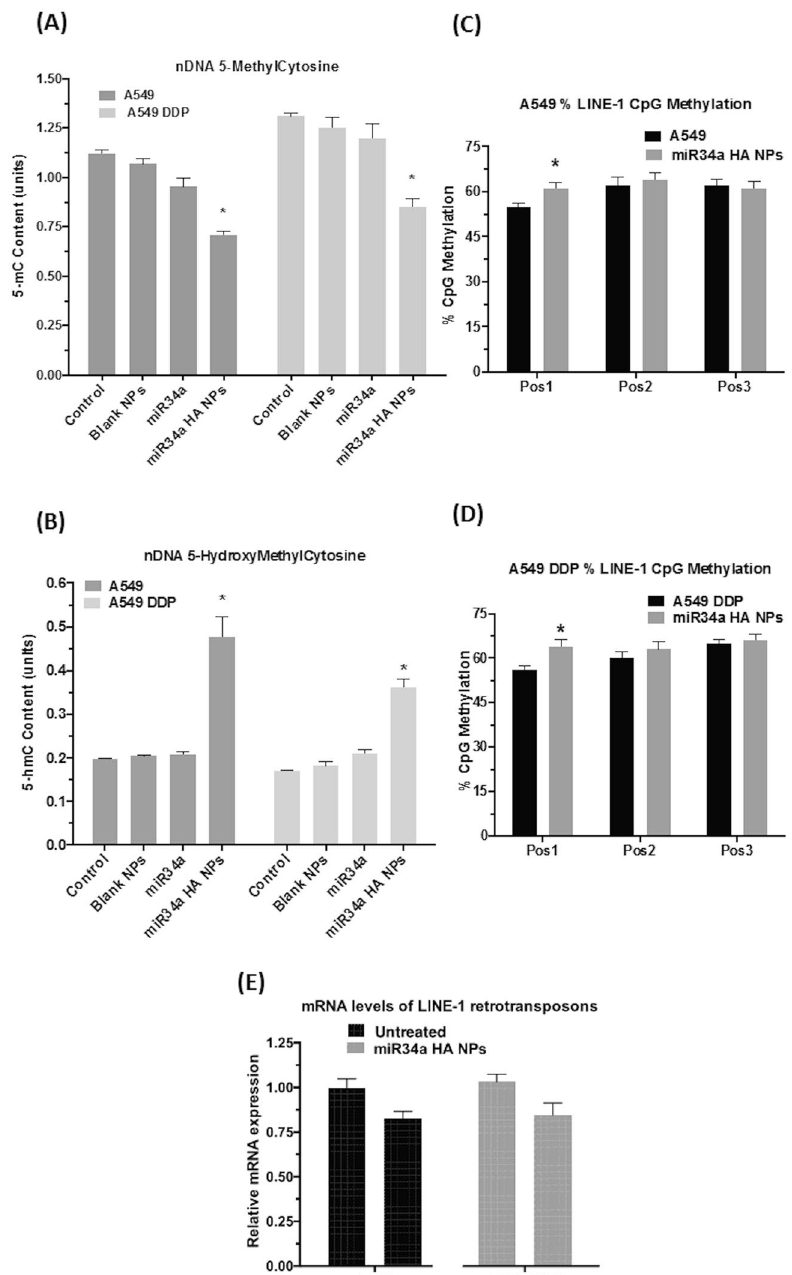
Figure 4. Effect of miR34a transfection with HA-based nanoparticles on nuclear DNA (nDNA) methylation levels. Nucleus was isolated from A549 and A549 DDP cells post-transfection with miR34a HA-NPs. DNA was isolated from this nucleus and global (A) 5-methylcytosine (5-mC); (B) 5-hydroxymethylcytosine (5-hmC) content were measured with equal amounts of nDNA using 5-mC and 5-hmC enzyme linked immunosorbent assay (ELISA) assays. Blank NPs–Blank HA-PEI/HA-PEG nanoparticles, miR34a - Naked miR34a without encapsulation, miR34a HA-NPs–microRNA34a encapsulated in HA-PEI/HA-PEG nanoparticles. (C , D) miR34 a HA-NPs induced changes in site-specific methylation content for individual CpG sites on the promoter regions of LINE-1Hs family as determined by bisulfite conversion followed by pyrosequencing. Pos1–3 indicates individual CpG sites. Results are expressed in units (mean + / − standard error of the mean [SEM]); N = 6; * p < 0.05 compared to the corresponding control. ( E ) mRNA levels of LINE-1 retrotransposons as measured by a quantitative real time polymerase chain reaction (qRT-PCR) assay on the cells post-transfection with HA- PEI/PEG-nanovectors encapsulated miR34a. Normalized to Beta-Actin as well as untreated A549 or A549 DDP control cells using relative quantification by delta(delta(Ct) method. Results are expressed in units (mean + / − standard error of the mean [SEM]; n =